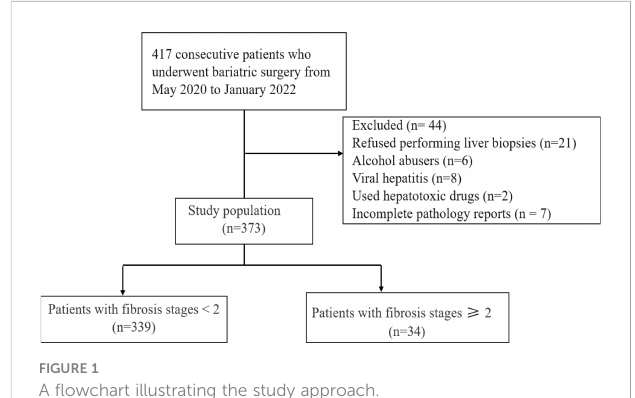
FIGURE 1 A fl owchart illustrating the study